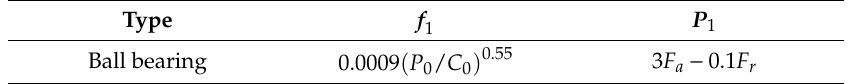
Table 3. Calculation method of coe ffi cient related to bearing type / load and calculated load